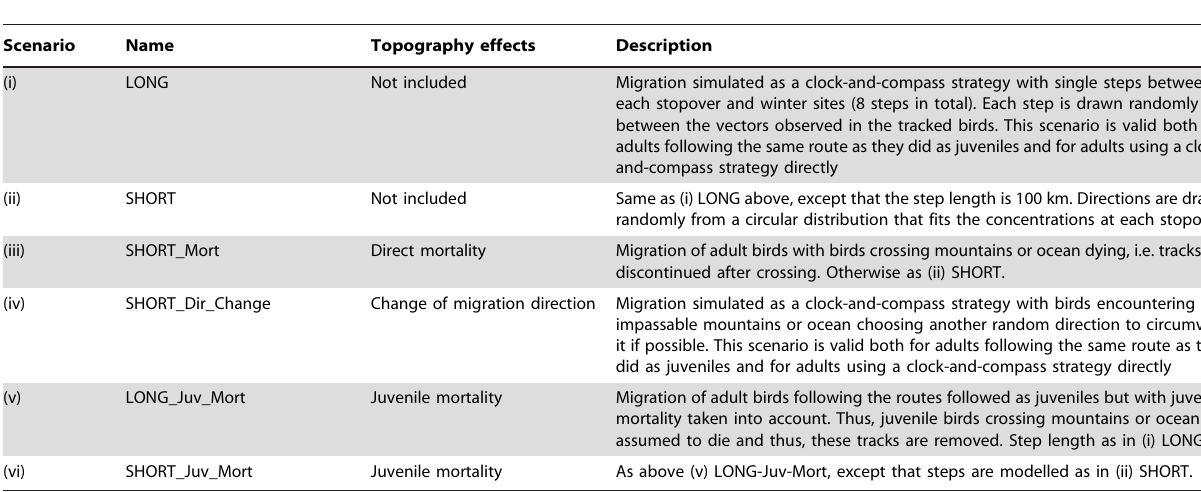
Table 1. Description of the different migration scenarios simulated. See Methods for more details.